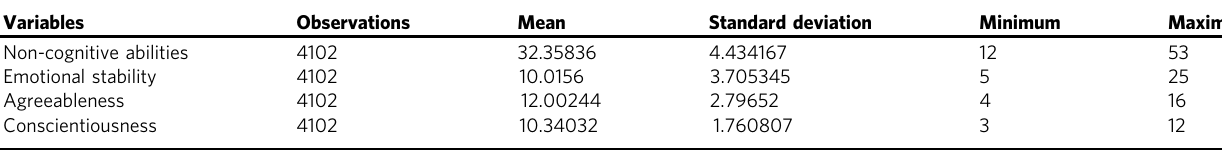
Table 3 Description of sample non-cognitive abilities. Variables